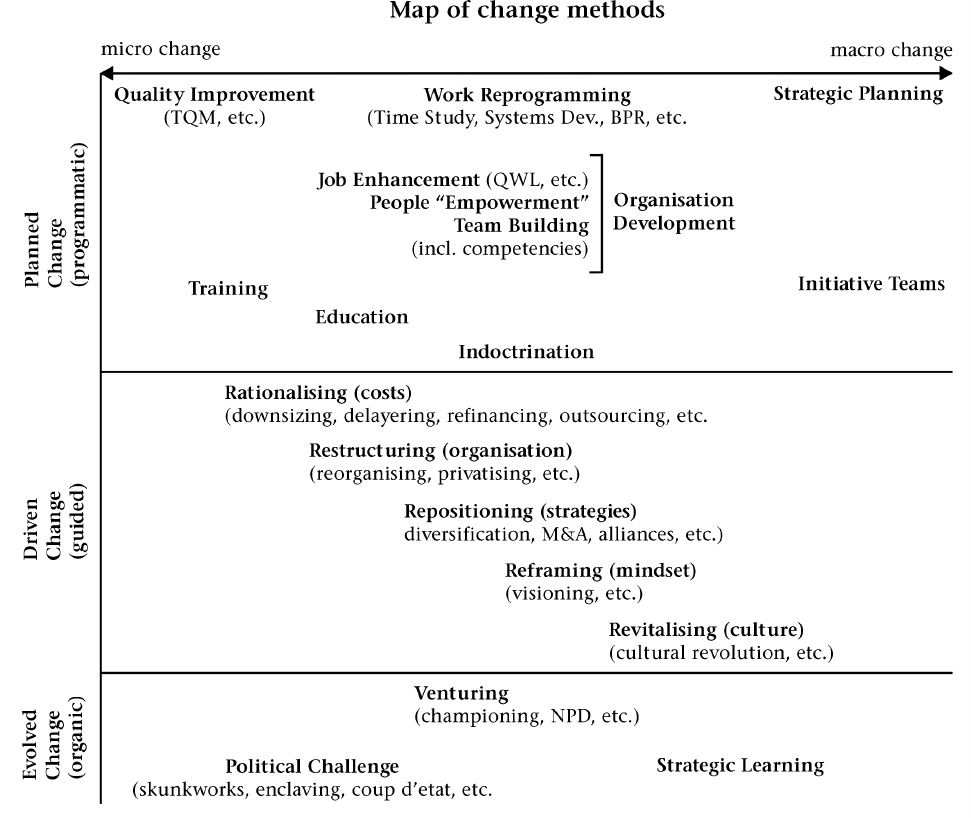
Figure 1: Map of change methods © Henry Mintzberg, August